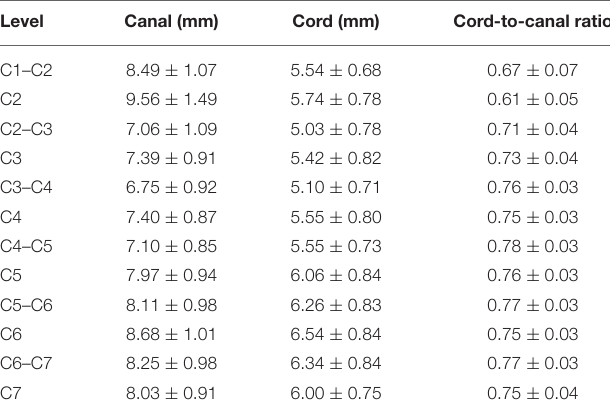
TABLE 2 | Heights of the spinal canal and cord measured on transverse images and ratio of the height of the spinal cord to the canal.